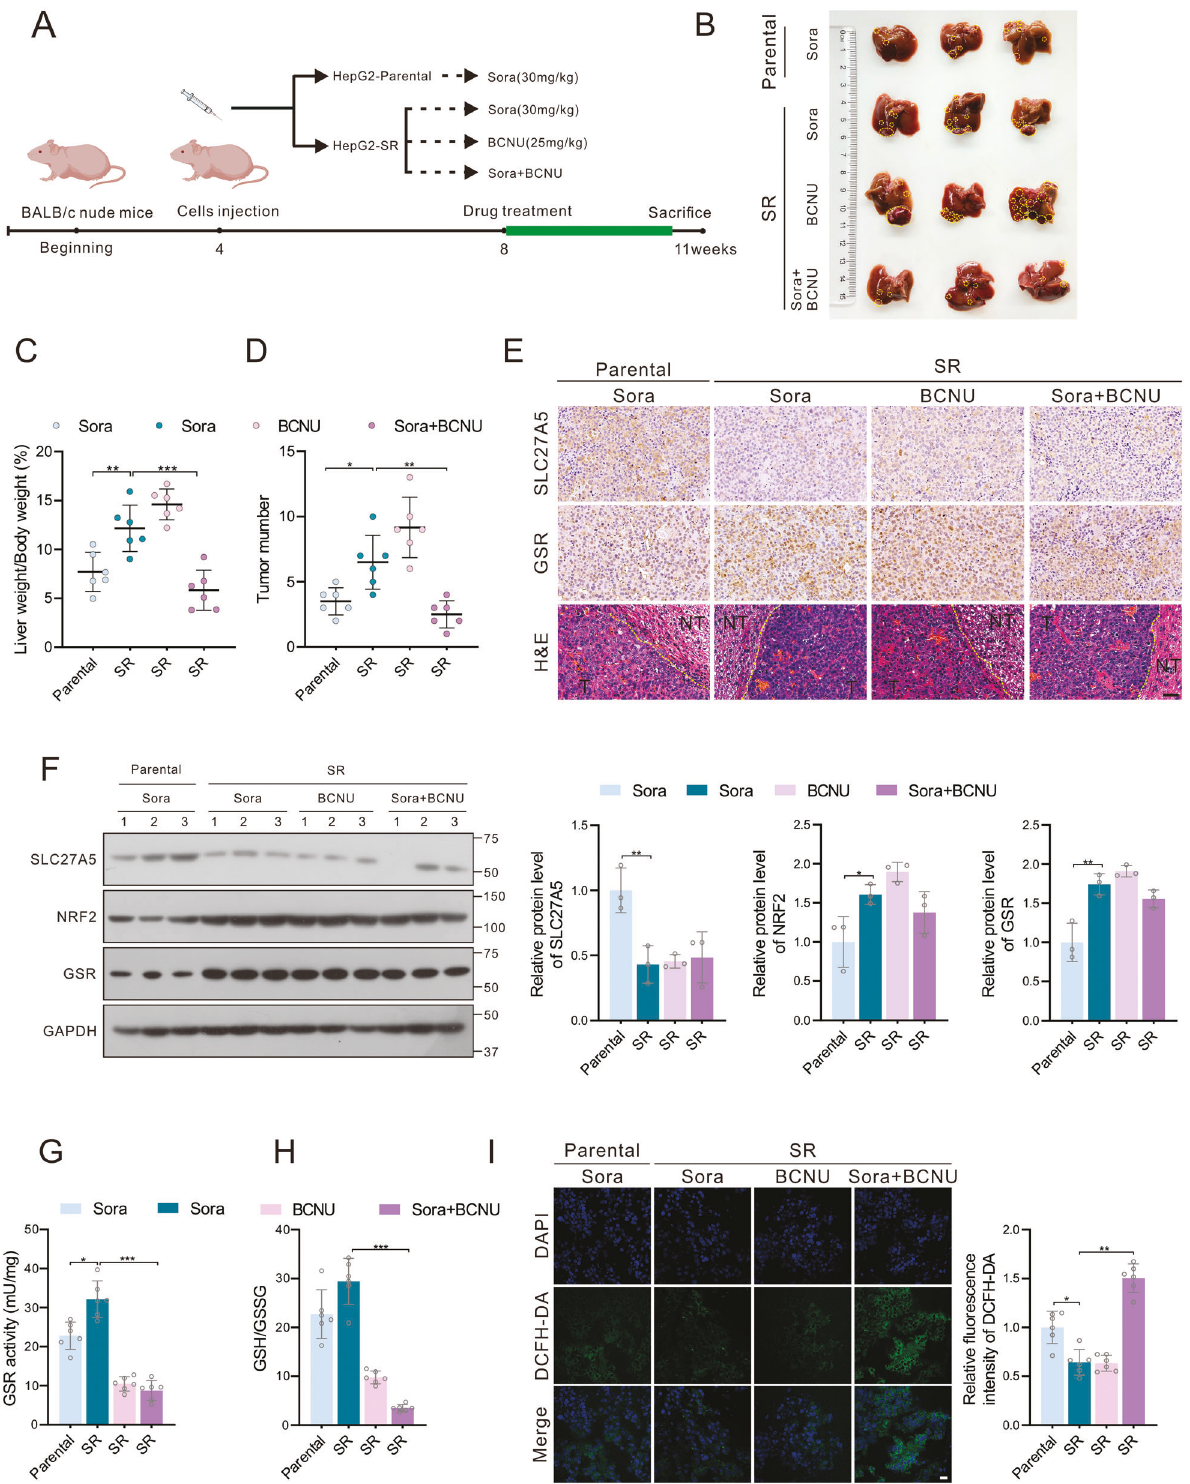
Fig. 7 BCNU enhances the curative effect of sorafenib in vivo by inducing ferroptosis. A Establishment protocol for the evaluation of tumor growth and resistance of human HepG2-parental and HepG2-SR tumor xenografts in BALB/C nude mice following therapy with sorafenib and BCNU alone or both. B Gross images of the HepG2-derived xenografts in orthotopic implantation model. C , D Analysis of liver/body weight ratio ( C ) ( n = 6) and tumor numbers ( D ) ( n = 6). E , F Relative protein expression of SLC27A5 and GSR in the tumor tissues was assayed by immunohistochemistry ( E ) and immunoblotting ( F ). Scale bar: 50 μ m. G – I The level of GSR activity ( G ) ( n = 6), GSH/GSSG ratio ( H ) ( n = 6), and ROS ( I ) ( n = 6) were assayed in tumor tissues. Scale bar: 10 μ m. Data shown are mean ± SD. Statistical signi fi cance was calculated using one- way ANOVA test. * p < 0.05, ** p < 0.01, *** p < 0.001.